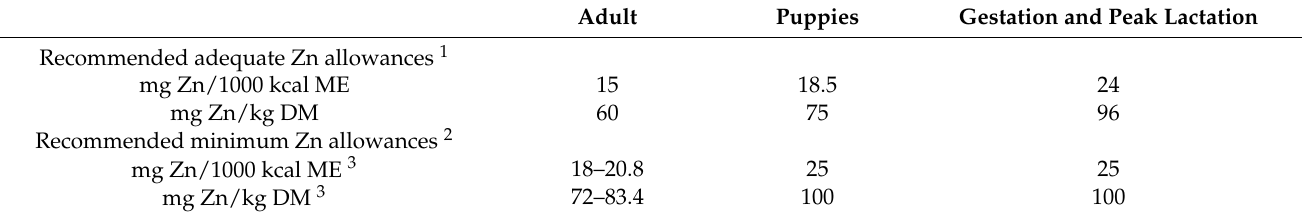
Table 1. Adequate and minimum recommended allowances of zinc for healthy dogs, defined by the National Research Council (NRC) and the European Pet Food Federation (FEDIAF). Adult Puppies Gestation and Peak